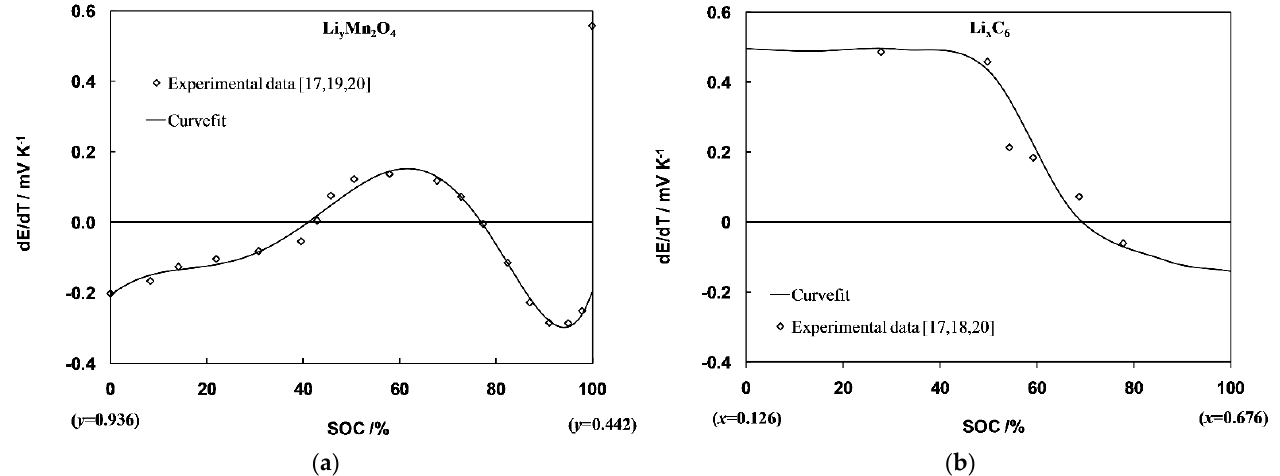
Figure 6. Experimental data of entropic coefficients of the half cells and the corresponding best-fit curves for ( a ) Li y Mn 2 O 4 (positive electrode) [55 – 57] and ( b ) Li x C 6 (negative electrode) [57 – 59] . Reprinted with permission from [38] . Copyrights 2013 Elsevier.